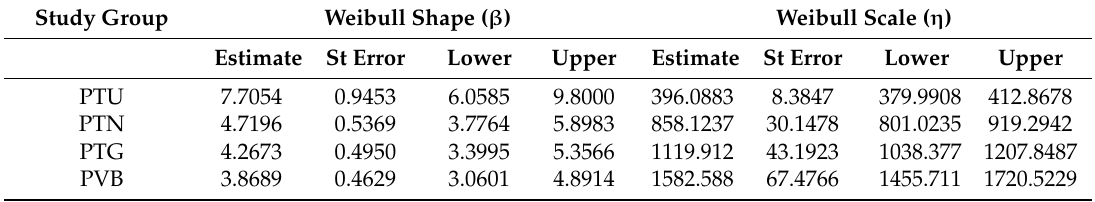
Table 4. Weibull statistics of the number of cycles to failure for the study groups.